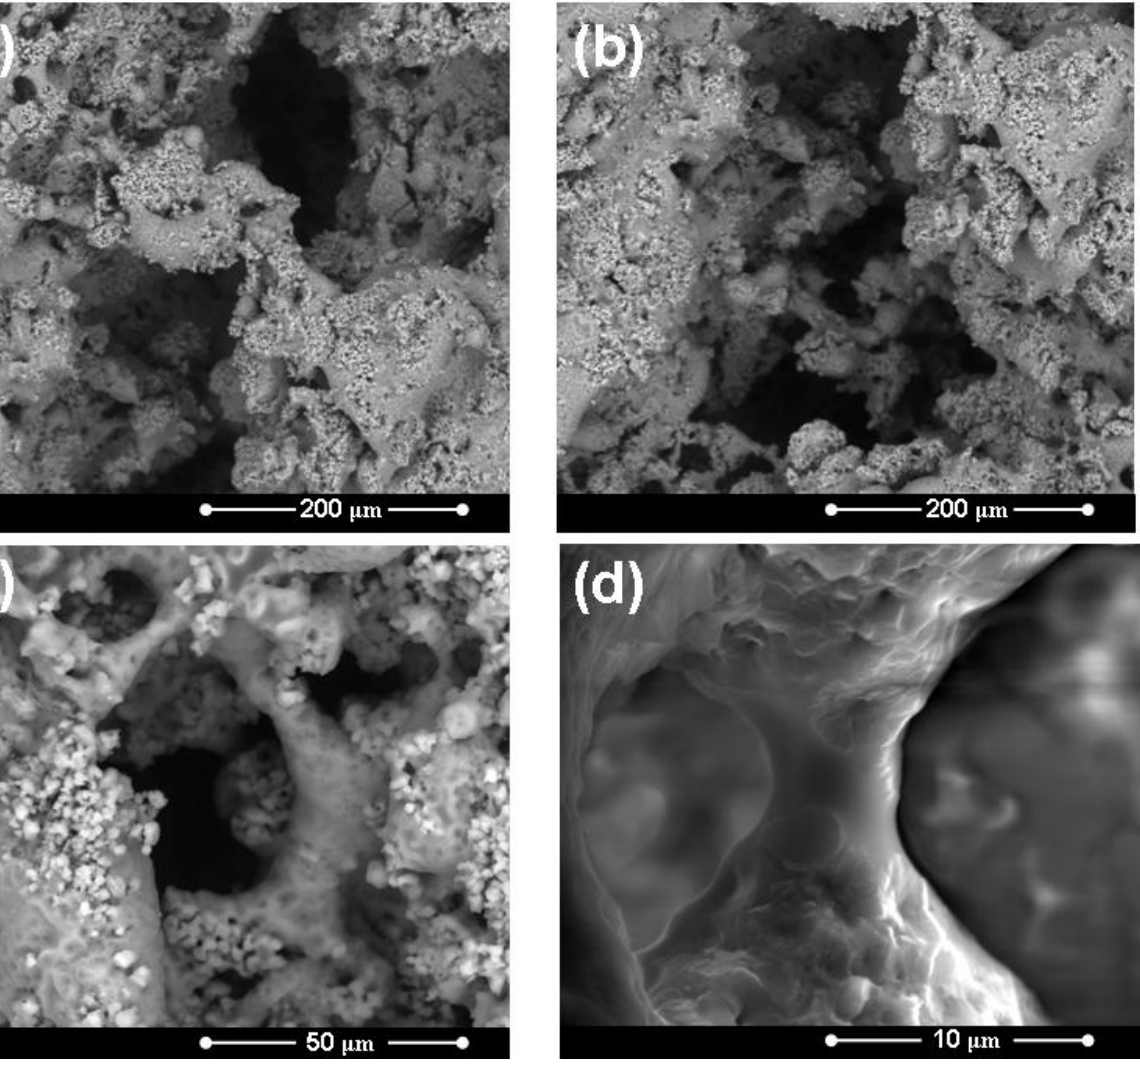
Figure 10. Images of the scaffold during the capillarity test. The sample was treated at 750 °C for 3